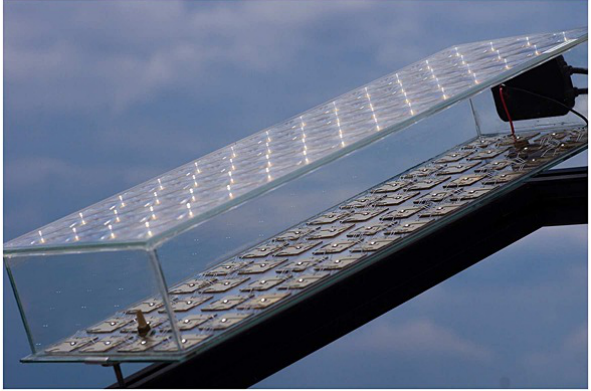
Figure 5. FLATCON ® CPV module with 52 four-junction solar cells